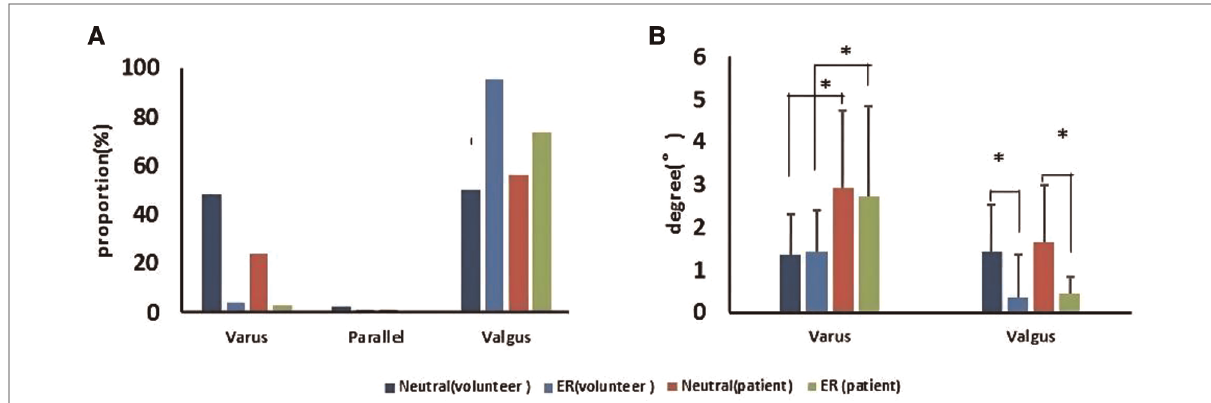
FIGURE 5 The MTCL – TMA angle in volunteers and patients, in neutral and ER positions. ( A ) Proportions of the MTCL – TMA angle. ( B ) Ranges of the MTCL – TMA angle measurements (* p